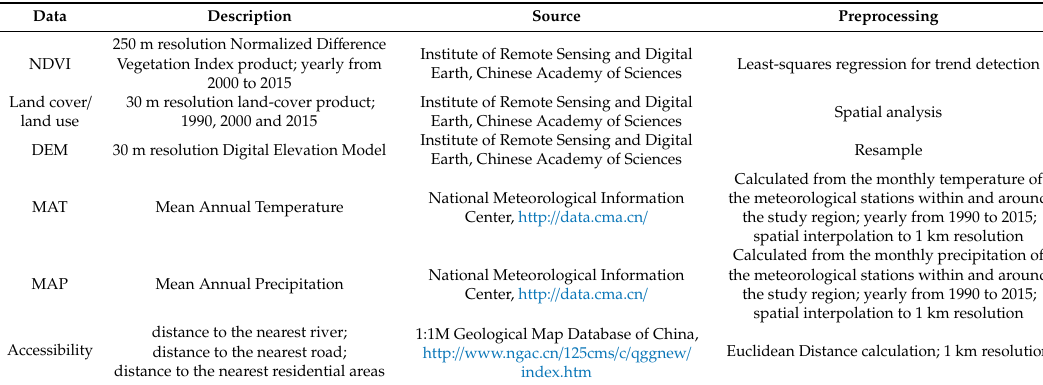
Table 1. Spatial datasets used in the